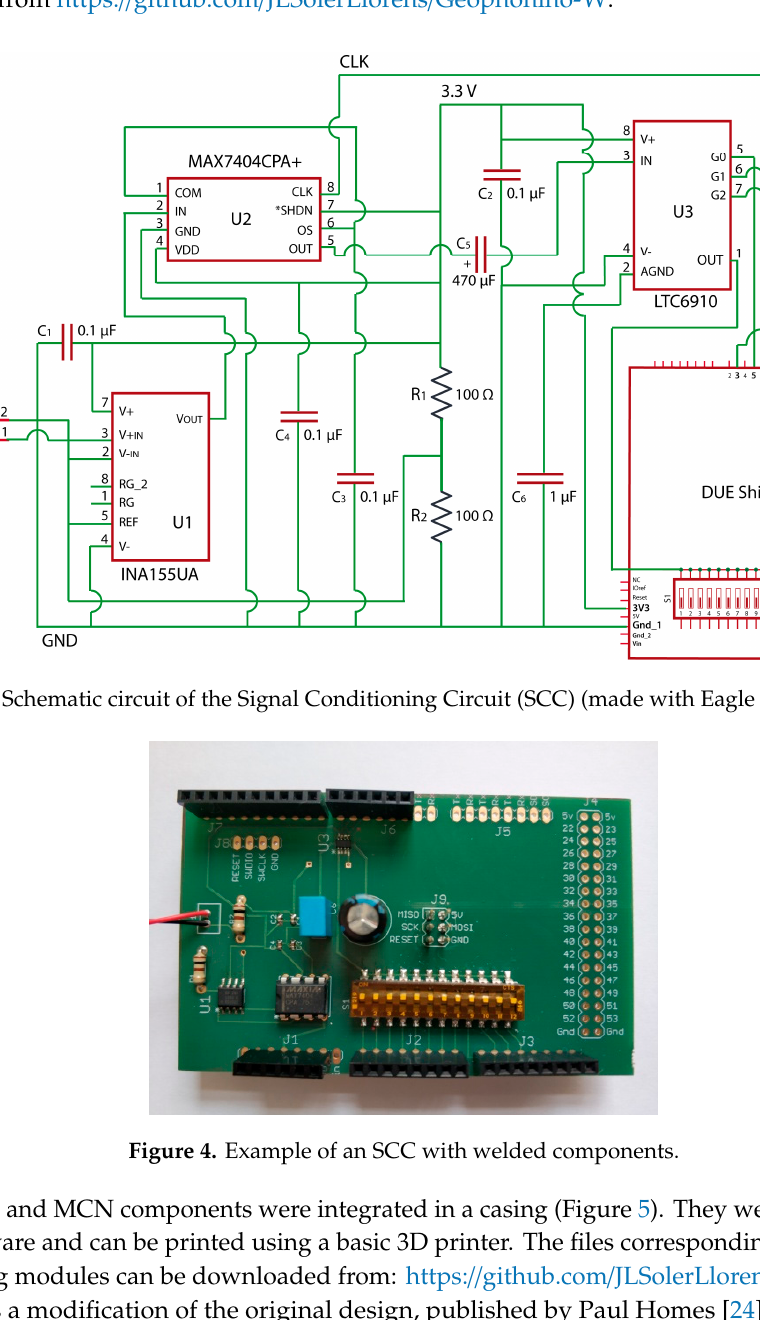
Figure 2. Diagram of the components and connections of the Acquisition Control Node (ACN) system.